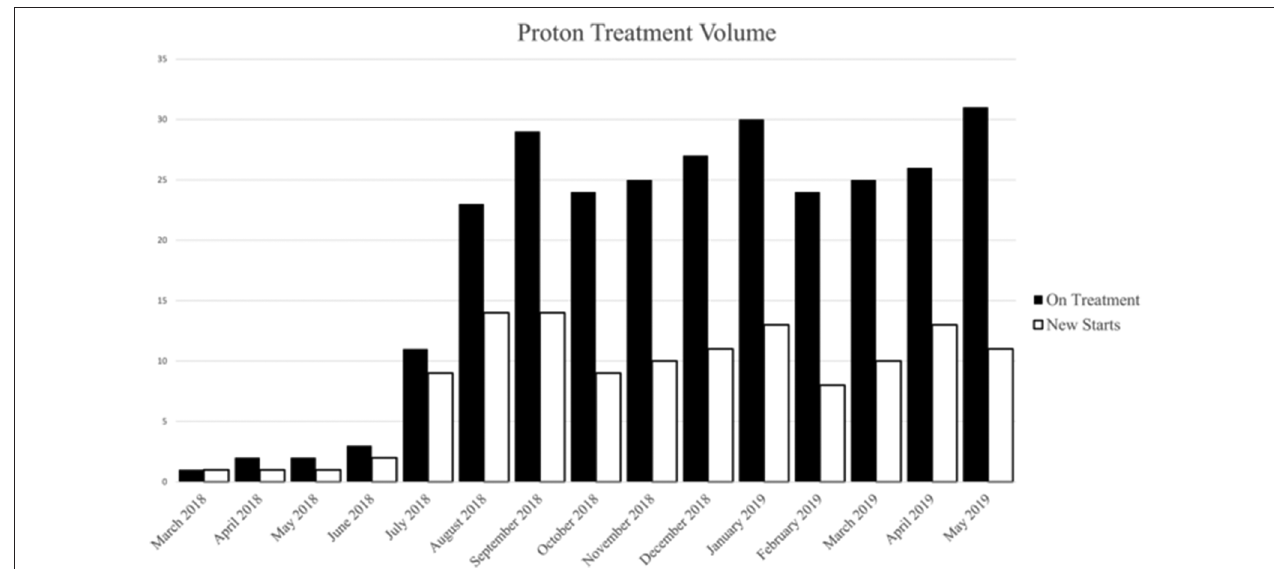
FIGURE 2 | Number of patients on treatment (white) and number of patient new starts (black) by month during the first year.